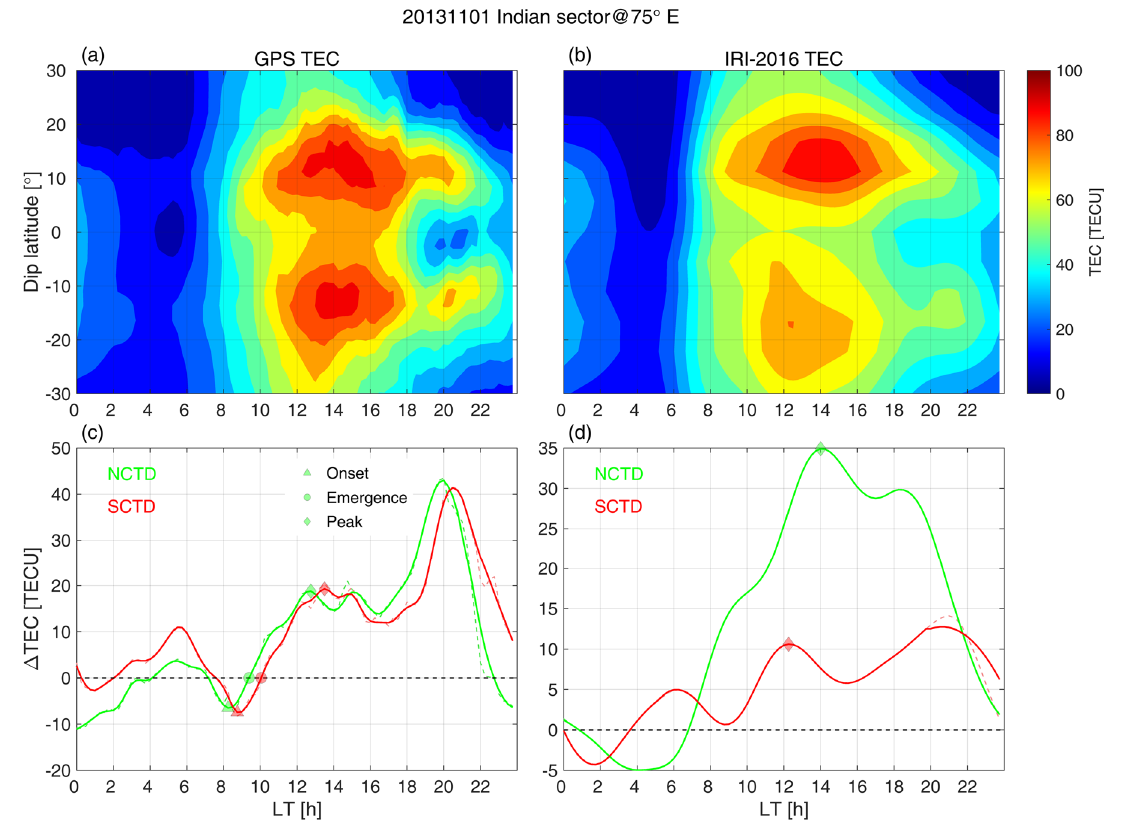
Figure 5. Top panels: TEC at Indian sector as a function of local time and dip latitude, using data from ( a ) IGS GPS TEC and ( b ) IRI-2016. Bottom panels: Local time evolution of the extracted NCTD and SCTD from ( c ) IGS GPS TEC and ( d ) IRI-2016. Dash curves are the original calculation from TEC data; solid curve is the smoothed results. The triangles, circles, and diamonds mark the time of the onsets, first emergences, and the peaks of the EIA crests during the evolution.